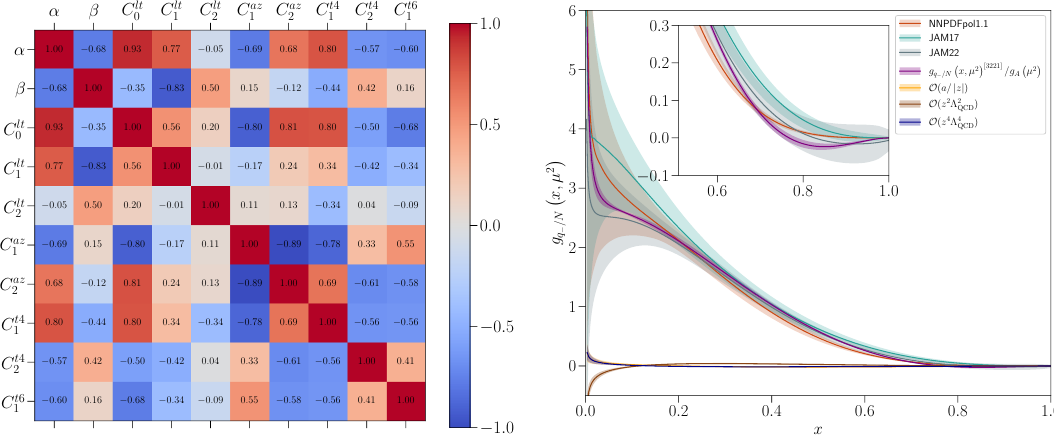
Figure 6 . (Left) Parameter correlations obtained from Cov ij / p Cov ii Cov jj of the fit presented in figure 5. (Right) Derived leading-twist valence helicity quark PDF (purple) and x -space contami- nations compared with the recent global analyses NNPDFpol1.1 [12], JAM17 [23], and JAM22 [26].